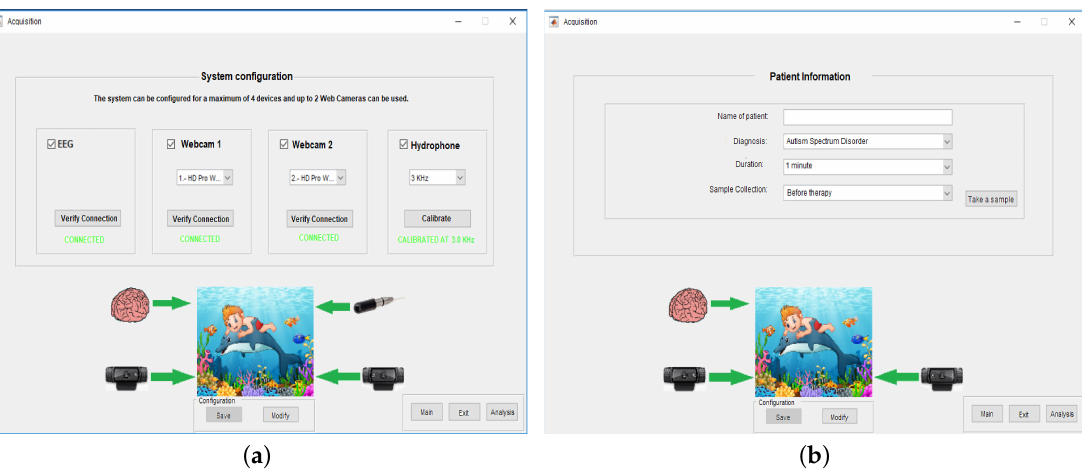
Figure 11. Integrated Development Environment for HSS-Cognitive. ( a ) System Configuration Windows and ( b ) Patient Information